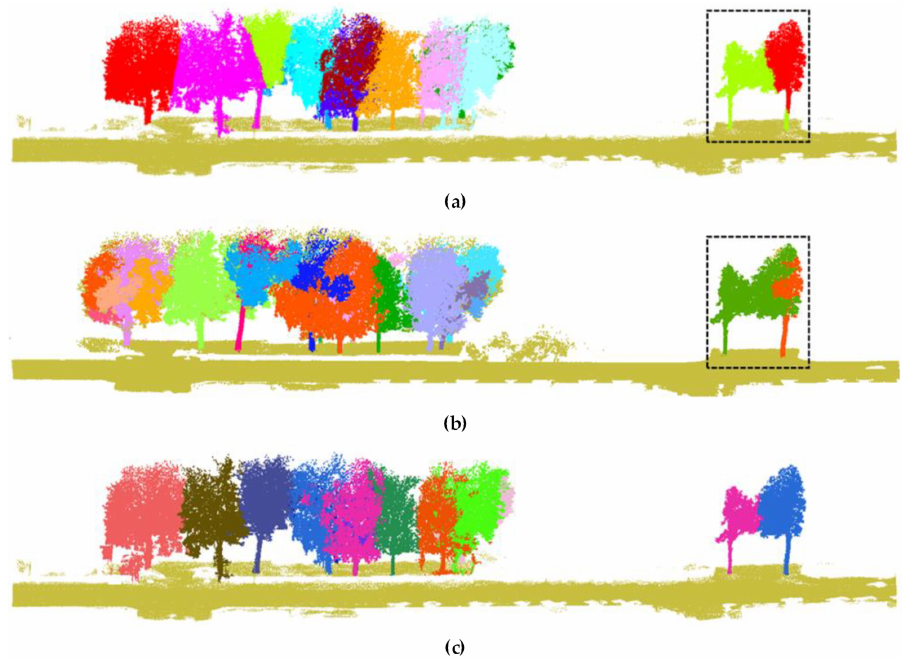
Figure 15. Comparison in Scene 4. ( a ) Clustering based method [44]. ( b ) 3D Forest method [30]. ( c ) Our method.